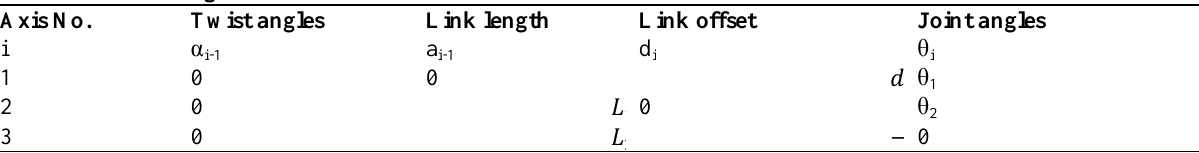
Denavit-Hartenberg Parameters